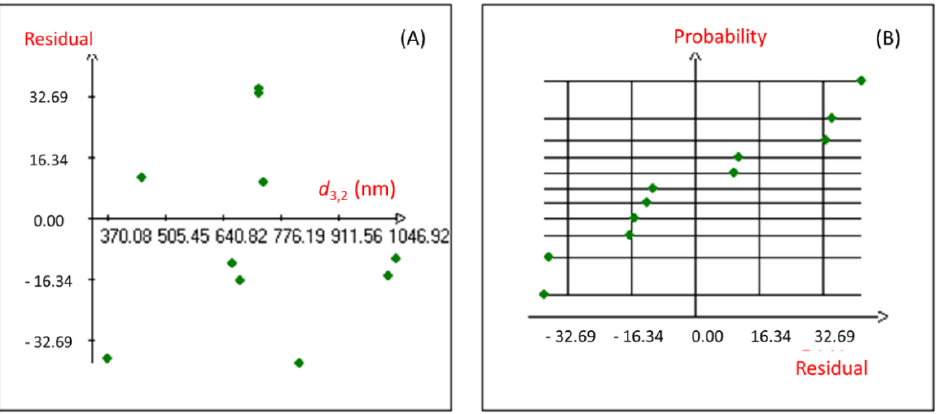
Figure 1. Graphical study of the residuals of the nanoemulsion droplet size diameter. ( A ): Graphic study of residuals; ( B ): Normal Plot of